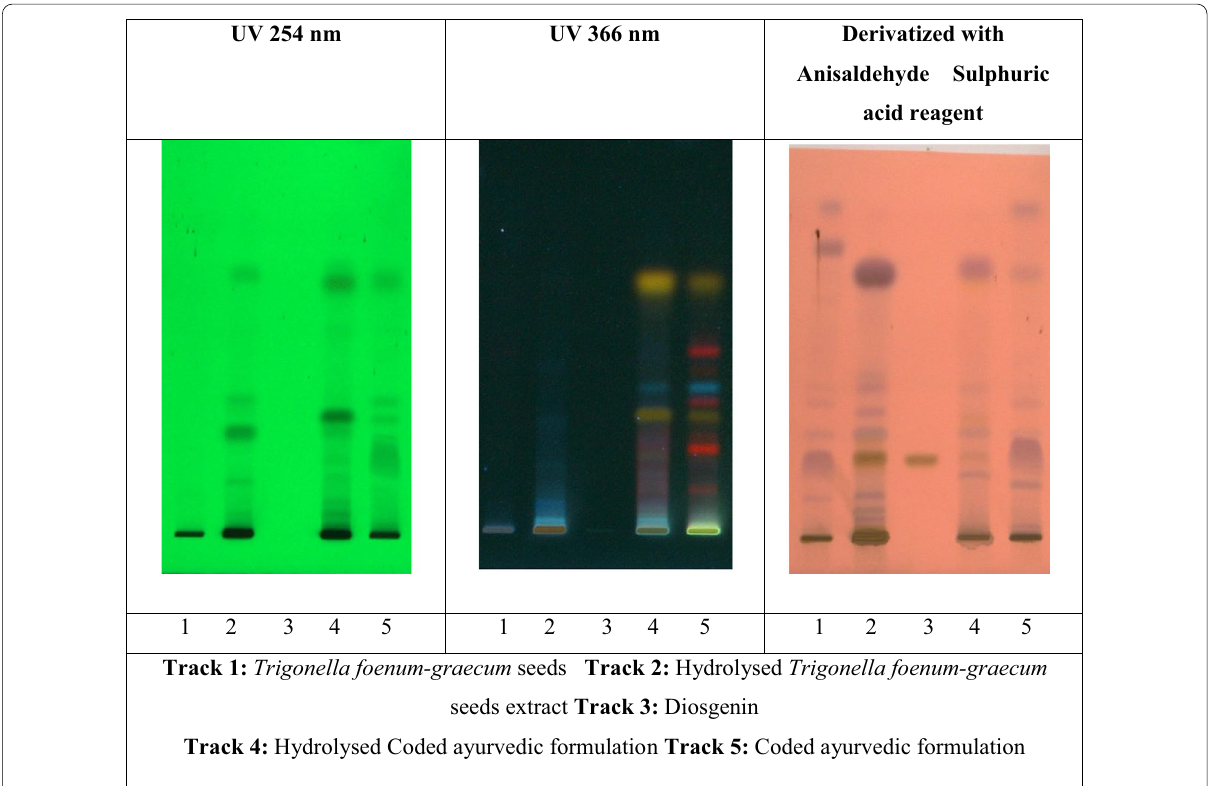
Fig. 3 HPTLC fingerprint profiling of Trigonella foenum-graecum, coded ayurvedic formulation and Diosgenin reference